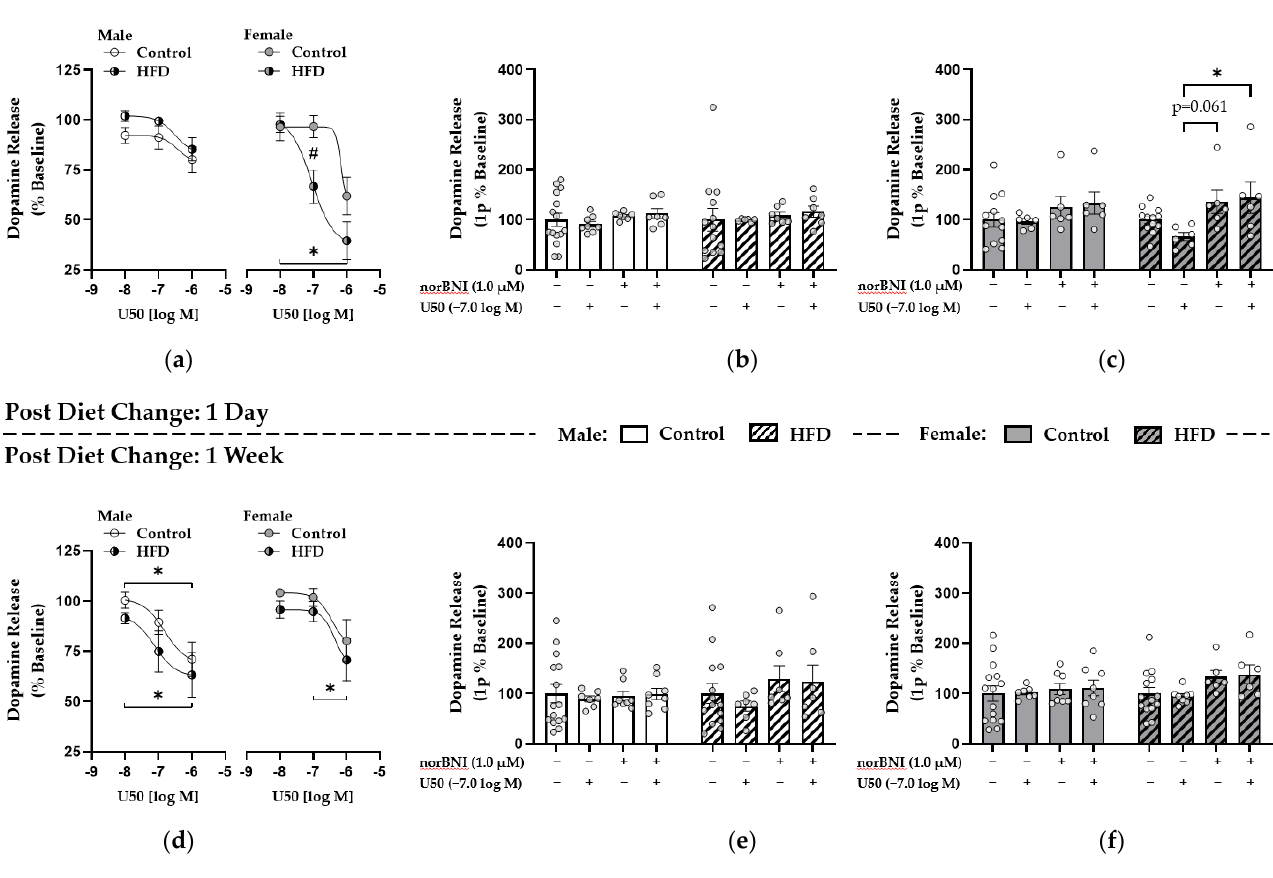
Figure 5. κ -Opioid Receptor (KOR)-Mediated Control Over Dopamine Release within the NAc Core During HFD Replacement. Effects of KOR agonism with (-)-U-50488 hydrochloride (U50) in males and females after one day of HFD replacement or pair-feeding in control groups ( a ) are displayed using 0.01 μM (−8.0 [log M]), 0.10 μM (−7.0 [log M]), and 1.0 μM ( −6.0 [log M]) U50. Interactions between KOR agonism with 0.10 μM U50 and KOR antagonism with 1.0 μM nor-Binaltorphimine dihydrochloride (norBNI) are shown for males ( b ) and females ( c ). Similarly, for the one-week HFD replacement and pair-feeding condition, the U50 drug curve is shown for males and females ( d ) with interactions between U50 and norBNI shown for males ( e ) and females ( f ). * denotes significant differences between U50 doses or between effects of U50 and norBNI; # denotes a significant diet effect within an individual dose of U50. *, p < 0.05; #, p < 0.05.